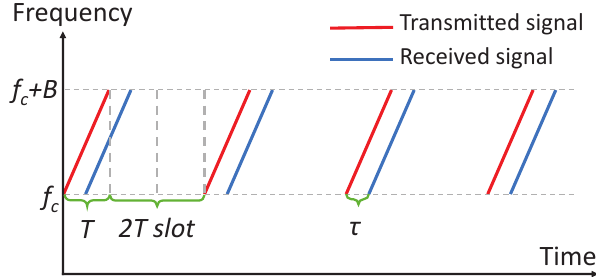
Figure 5. The FMCW chirp signal design.